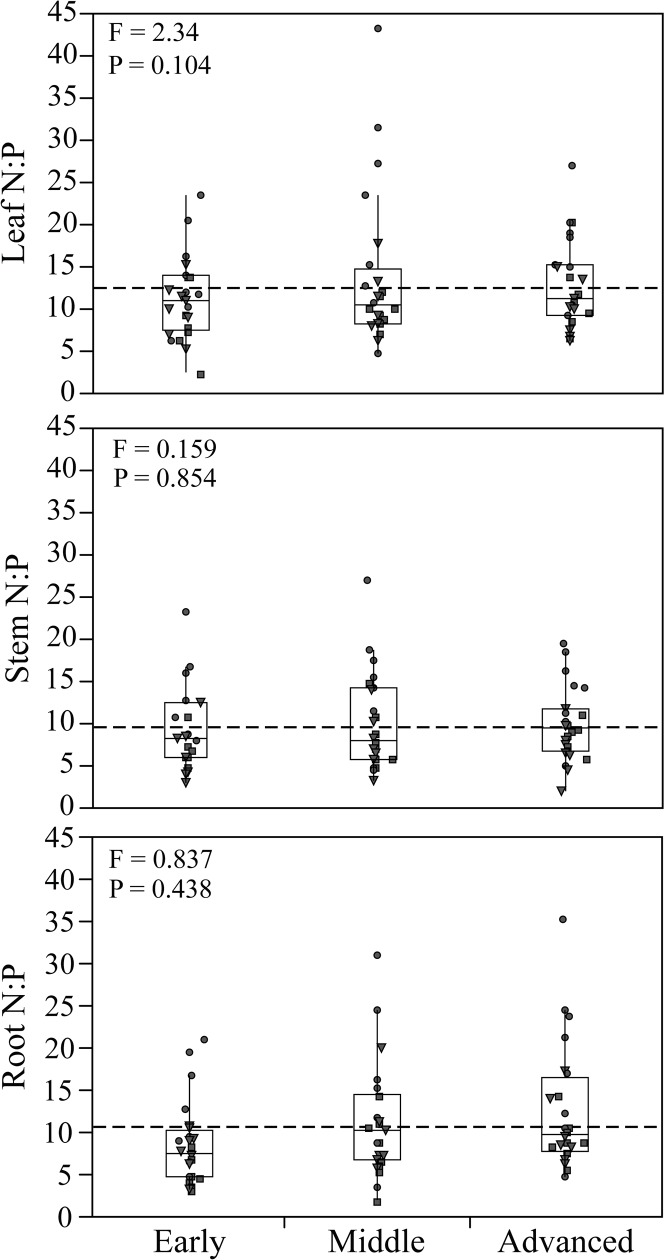
Variation in plant N:P ratios within different compartment (leaves, stems, roots) across the three successional stages (early, middle and advanced).Data points represent plant species belonging to different functional groups (Triangle = Grasses; Dots = Legumes; Squares = Forbs).